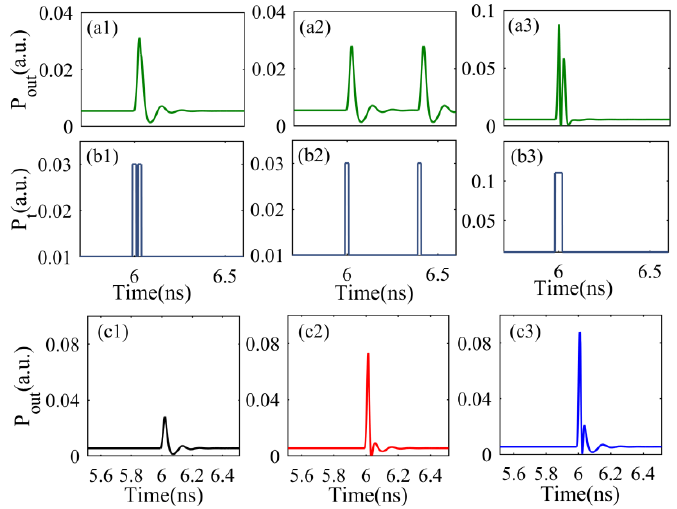
Figure 3. The response of MRR neuron ( a1 – a3 ) under external optical perturbation with different interval and duration time ( b1 – b3 ). ( c1 – c3 ) the output of MRR with perturbation strength 0.01,0.05,0.1 P , respectively.